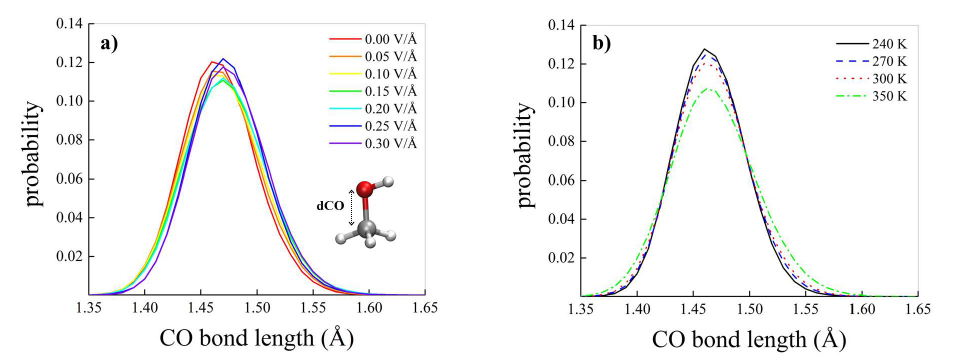
Figure 6. Distributions of the lengths of the CO covalent bonds in bulk liquid methanol determined for different field strengths at room temperature ( a ) and in the absence of the external field for diverse temperatures ( b